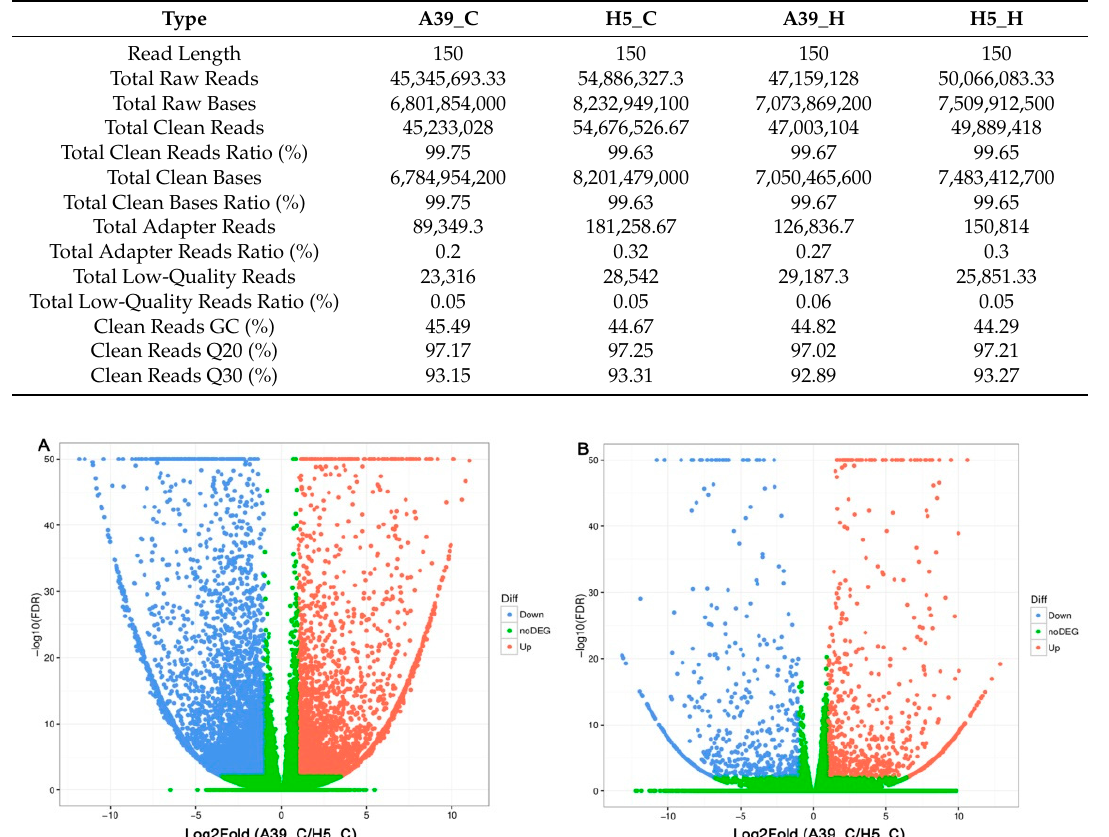
Figure 2. Comparison of different genes expression (DEGs) in leaves between A39 and H5 under normal conditions ( A ) and four days after heat stress ( B ). X- and y-axes represent log2 values of gene expression. Red, green, and blue correspond to up-regulated, unaltered, and down-regulated gene expression, respectively.